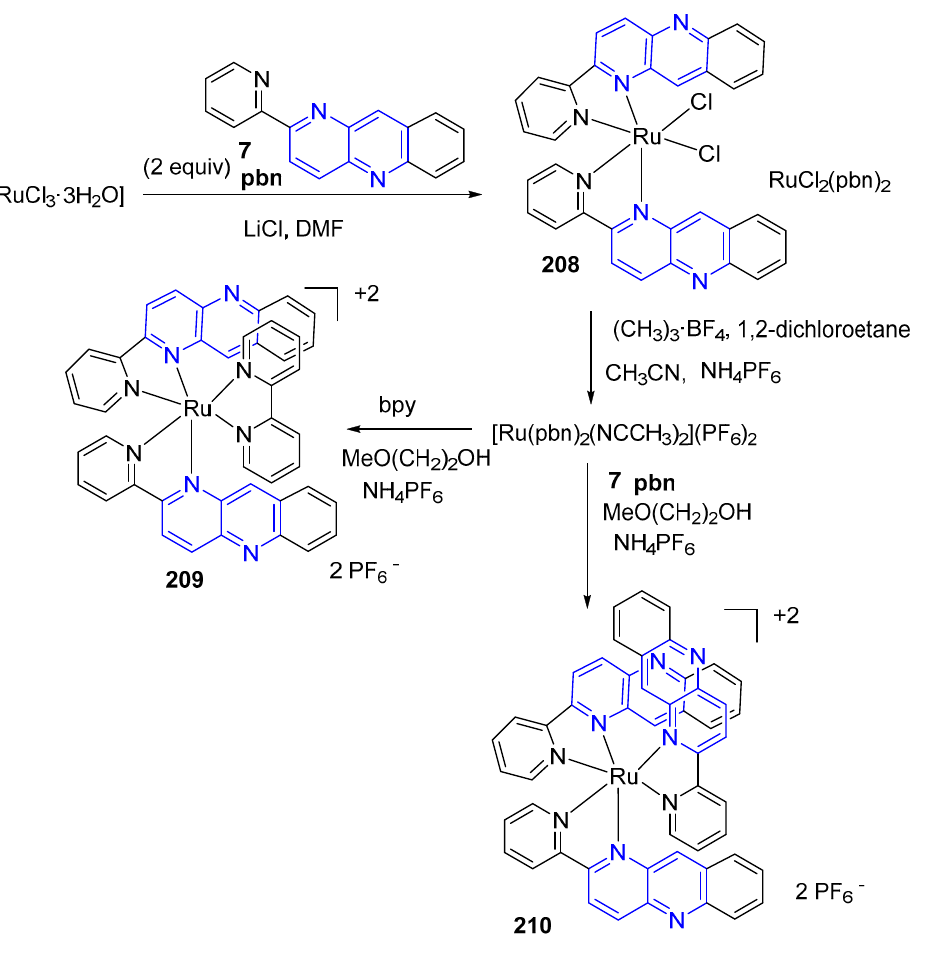
Scheme 63. Syntheses of pbn–ruthenium complexes.